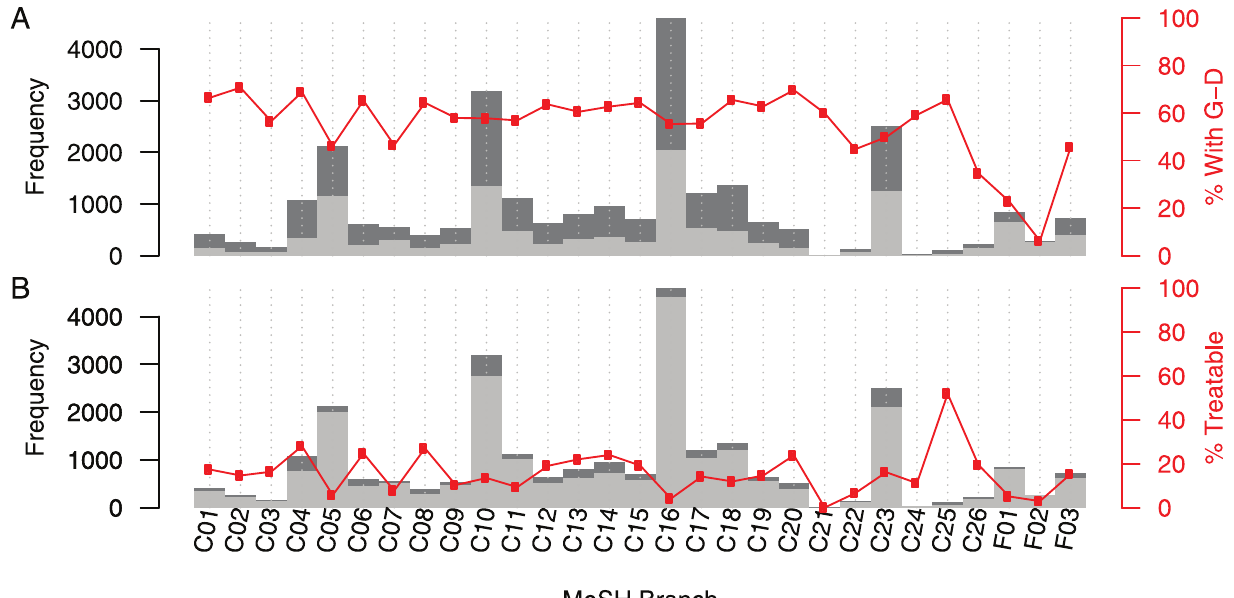
Fig 4. Identifying a therapeutic area of interest. (A) Dark grey shows the number of diseases in each therapeutic area of the MeSH hierarchy. Light grey shows the number of those diseases that are not involved in any of the gene-disease associations captured in our network. Red shows the number of diseases that are involved in a gene-disease association as a percentage of the total number of diseases in that therapeutic area. (B) Dark grey shows the number of diseases in each therapeutic area of the MeSH hierarchy. Light grey shows the number of those diseases that currently do not have a small molecule treatment on the market. Red shows the number of diseases that do have a treatment on the market as a percentage of the total number of diseases in that therapeutic area. Note : please see S1 Table for disease area